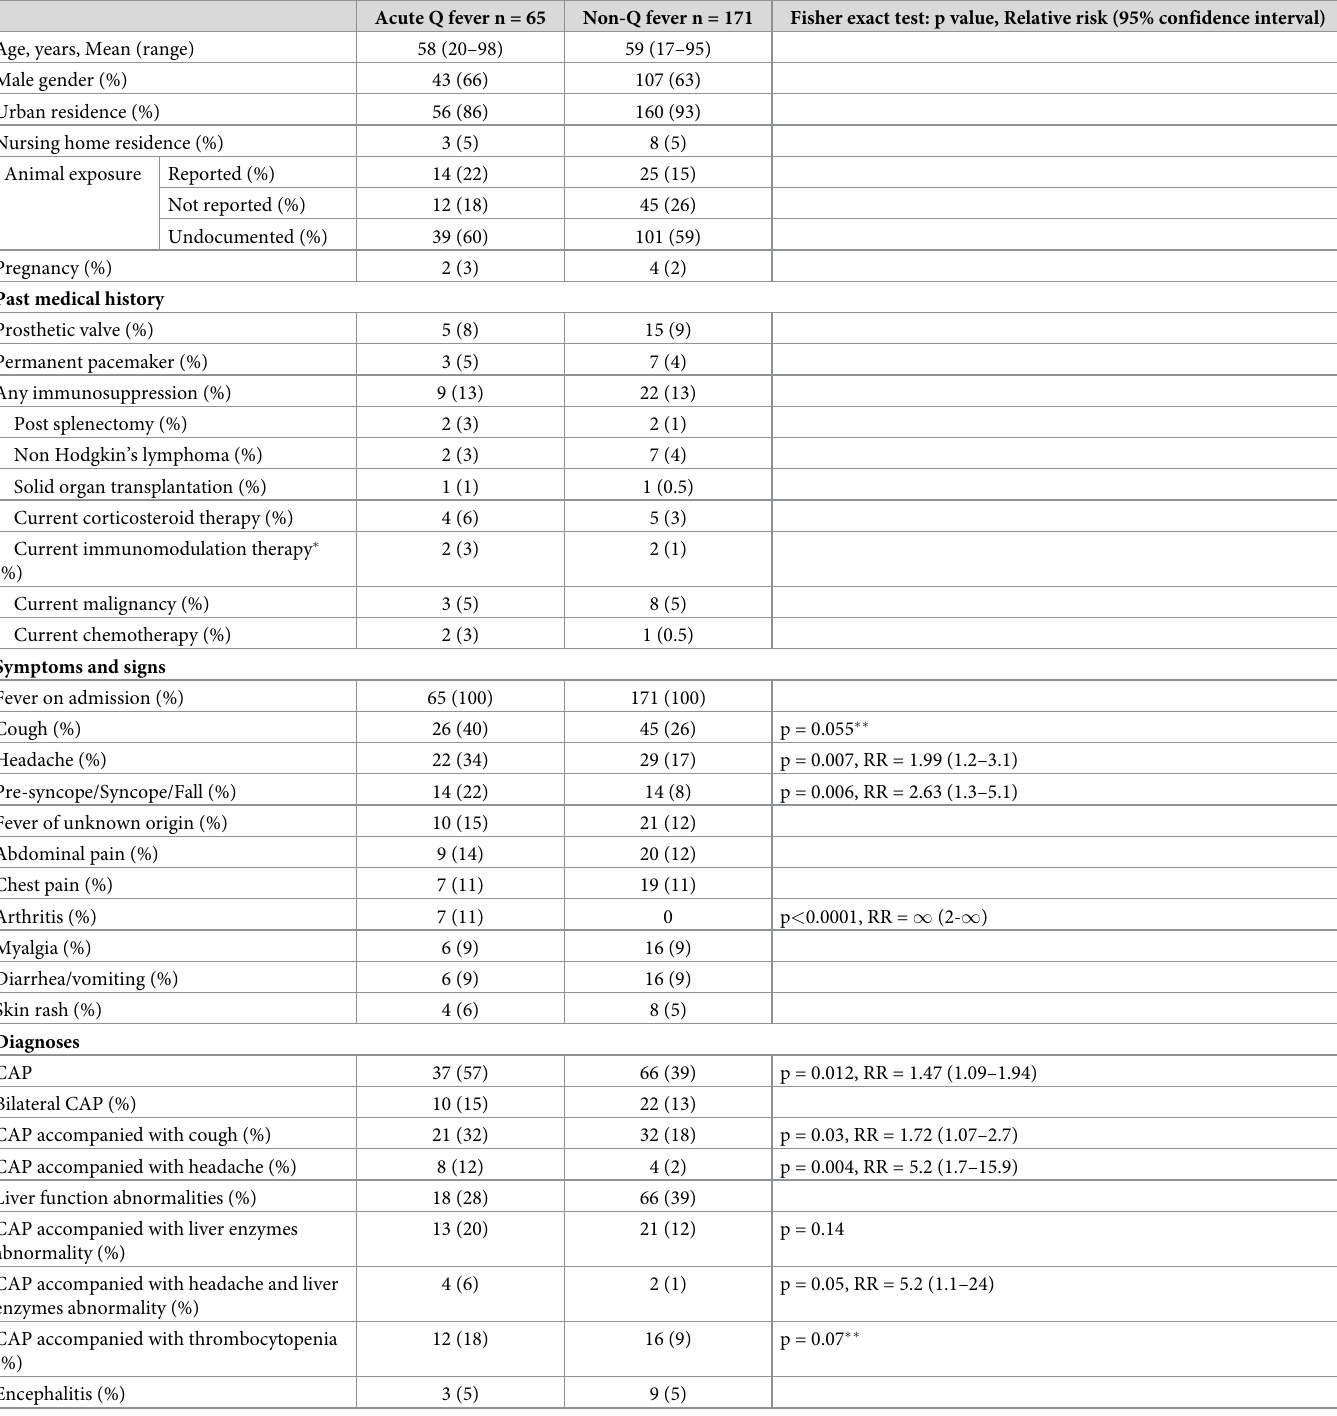
Table 1. Demographic and clinical characteristics of acute Q fever cases as compared with non-Q fever